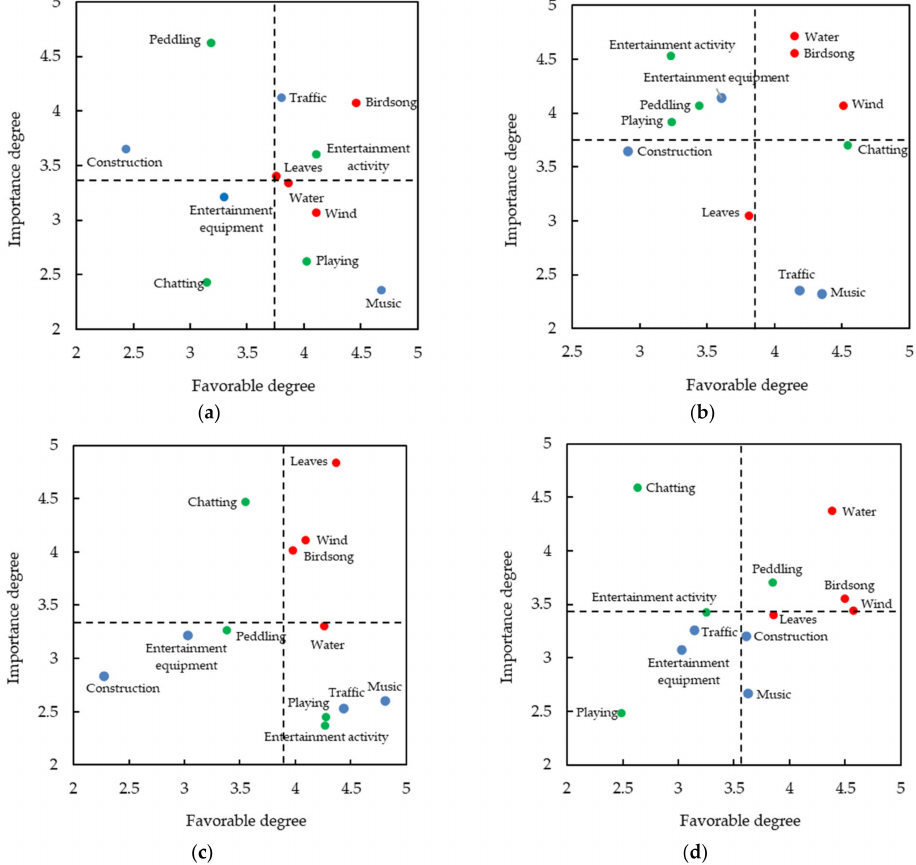
Figure 9. The importance-performance analysis (IPA) results of different types of the residents’ perceptions of urban park soundscapes. ( a ) Native-born residents; ( b ) first-generation immigrants; ( c ) second-generation immigrants; ( d ) residents with a foreign-registered residence. The dashed lines represent the average value of the importance and favorable degree of a certain type of resident to the urban park soundscape. The figure was created by the author. In addition, red dots in the figure represent natural sounds, blue dots represent artificial sounds, and green dots represent human